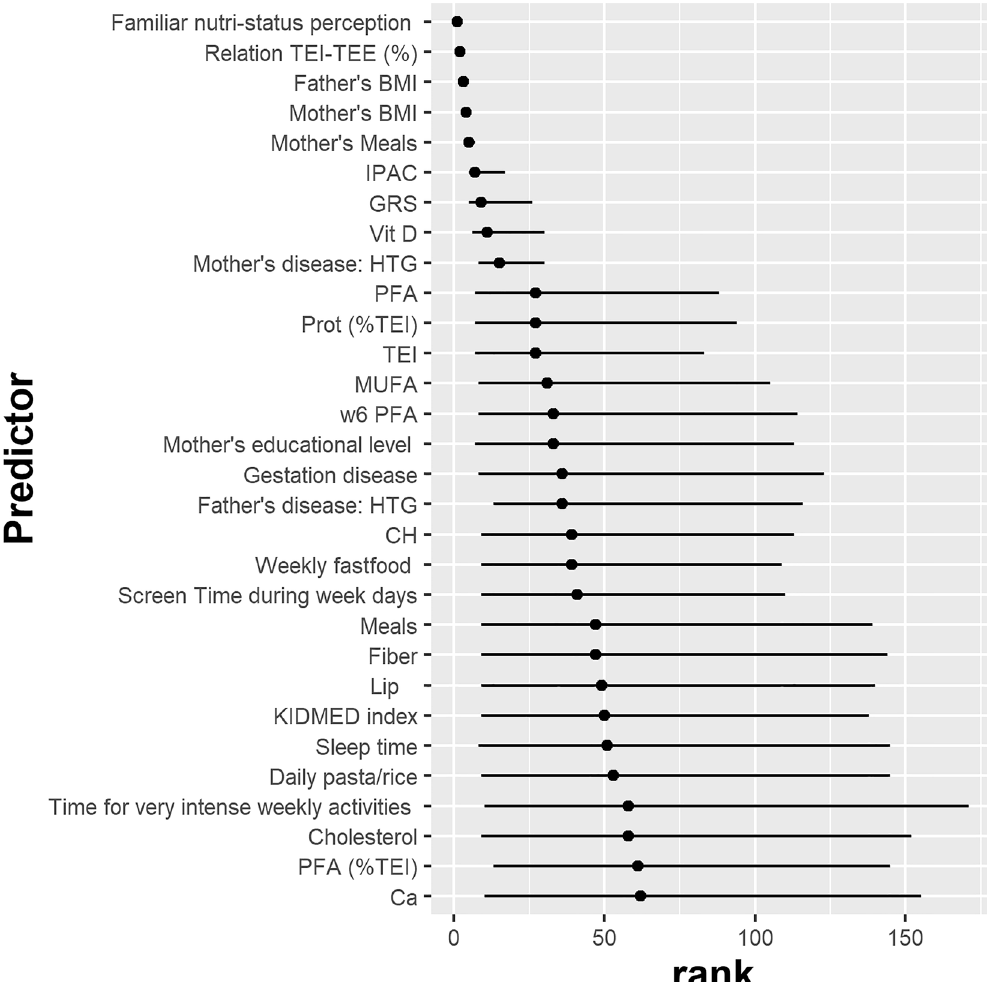
Figure 3. Mean average rank and 95% confidence intervals of the 30 most important predictor variables from the RF models to predict childhood